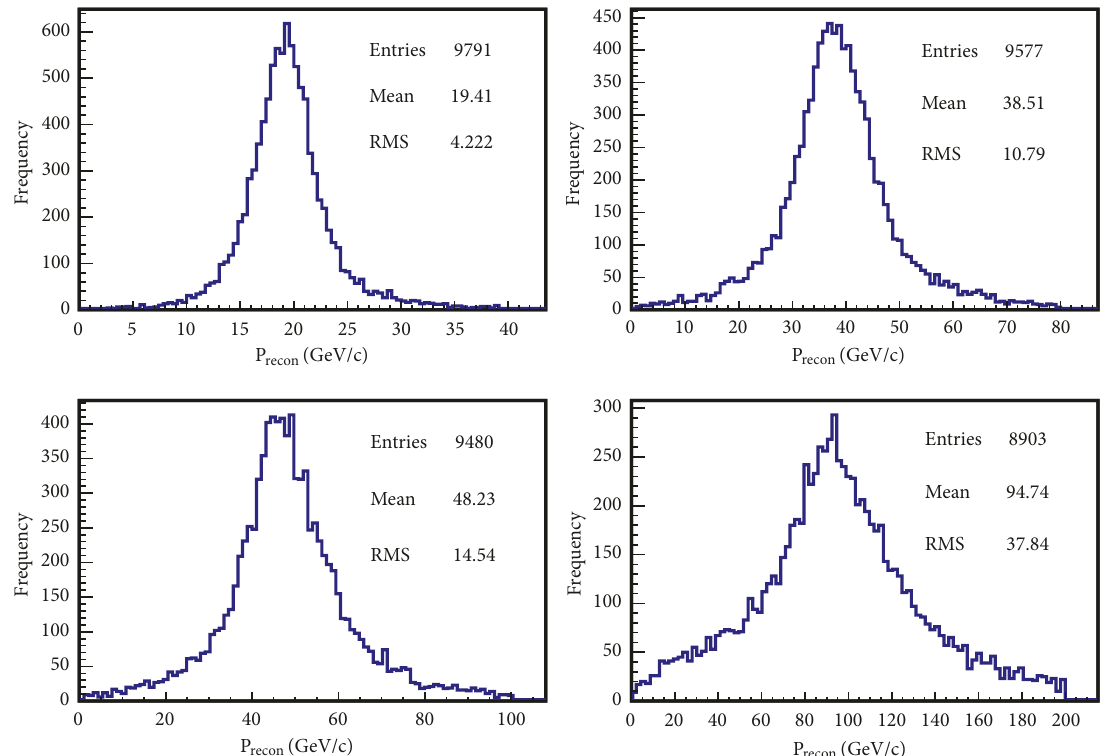
Figure 5: Reconstructed muon momentum distribution for four different values(20, 40, 50 and 100 GeV) of the input muon momentum and at fix zenith angle, cos 𝜃